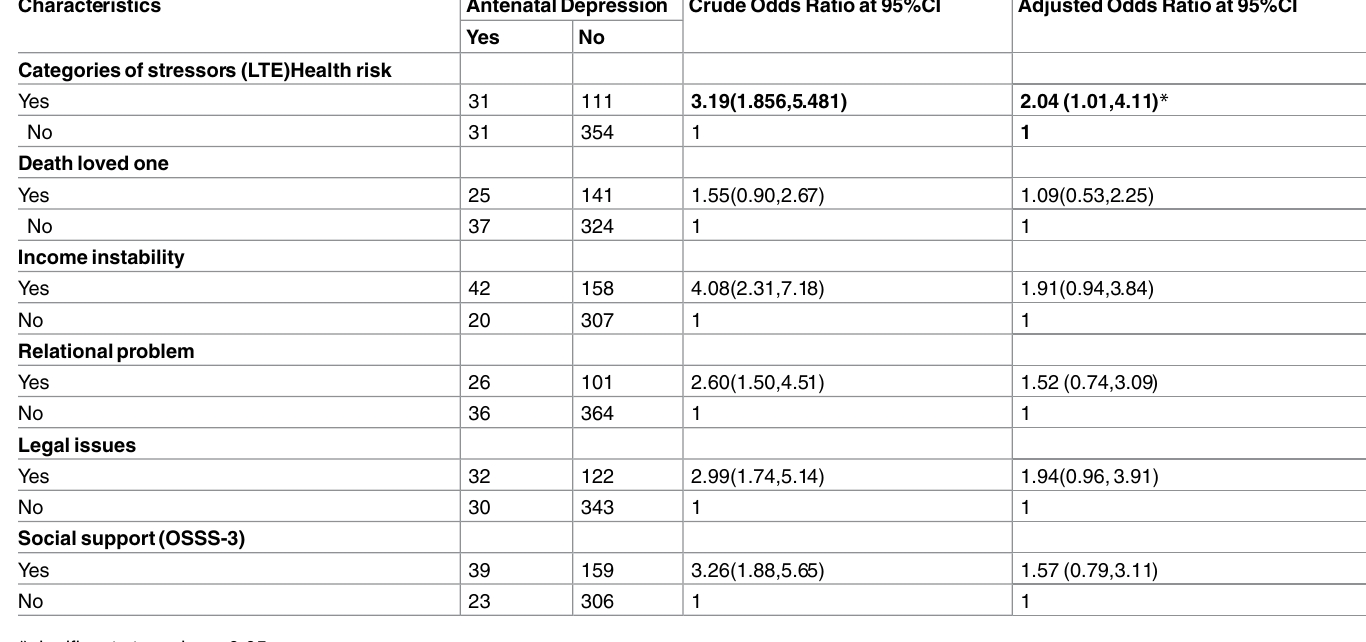
Table 3. Bivariateand multivariateanalysisof psychosocial factors(stressfulevents and socialsupport)and theirassociation withdepression amongpregnantwomen at Debretabortown, NorthWest Ethiopia,2013.